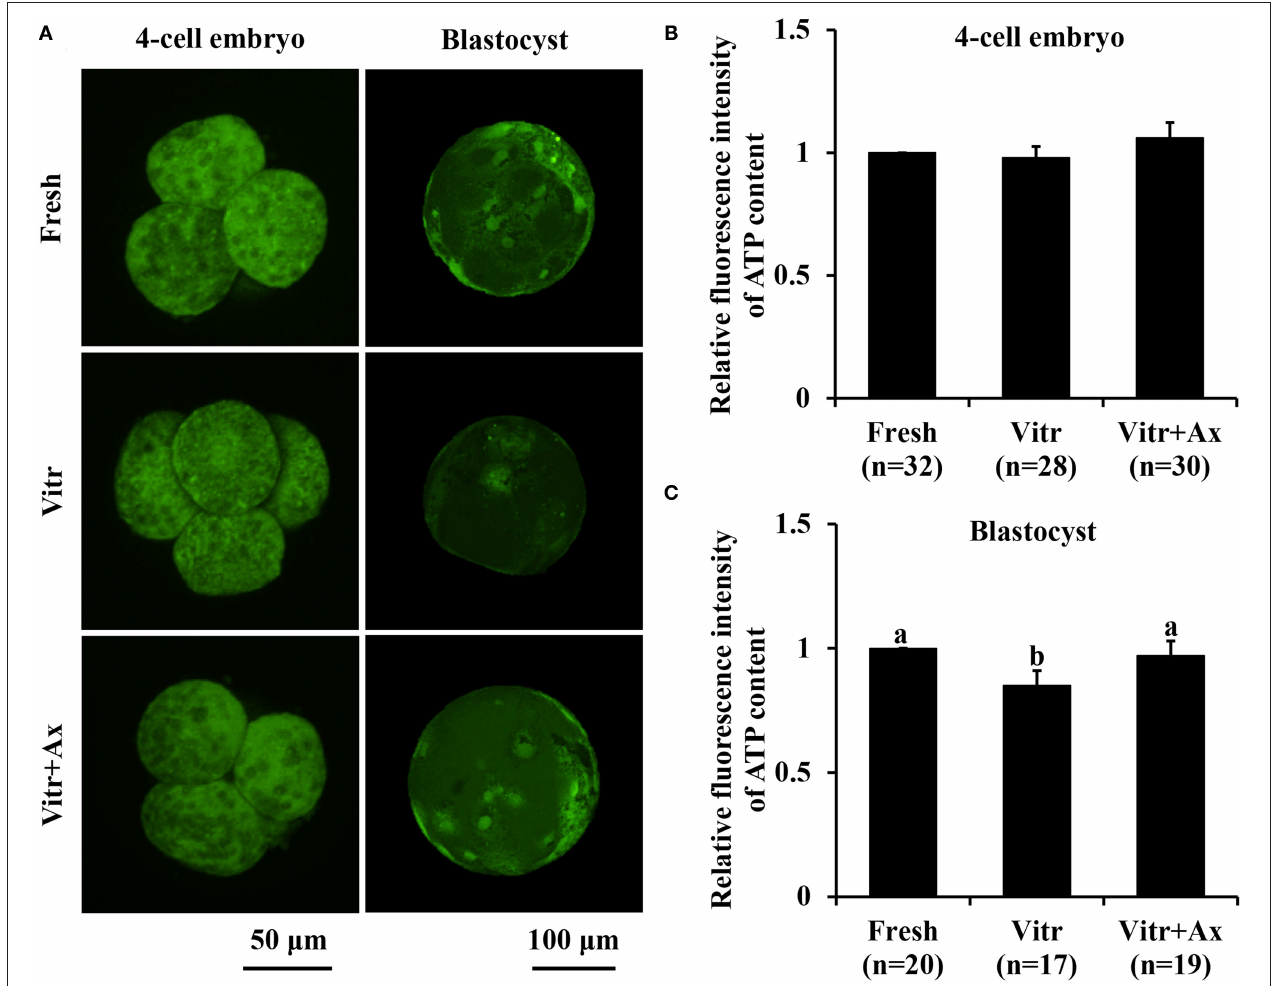
FIGURE 5 | Effects of astaxanthin (Ax) supplementation on intracellular ATP content in resultant 4-cell embryos and blastocysts. (A) Representative images of ATP signals stained with BODIPY FL ATP. (B,C) Graphical representation of ATP content by quantifying the relative fluorescence intensity. Four replications were performed. Data are the mean ± SEM values. Different superscripts above columns indicate significant differences ( P < 0.05). The three experimental groups: fresh zygotes (Fresh group), vitrified zygotes (Vitr group), and vitrified zygotes cultured with Ax (Vitr + Ax